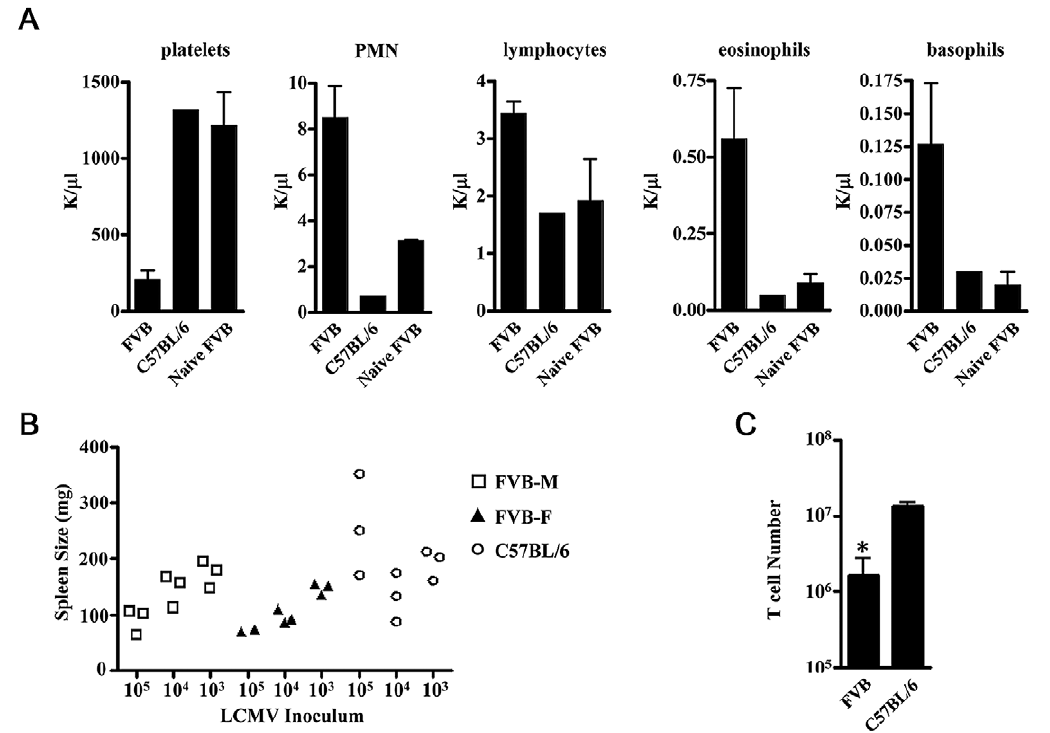
Figure 4. Effects of LCMV infection on blood and splenic cellularity in LCMV infected mice. A) Complete blood count with differential of LCMV-13 infected mice for platelet, neutrophil, lymphocyte, eosinphil and basophil counts. FVB (n=4) or C57BL/6 (n=1) mice were infected with 1– 2 6 10 6 p.f.u. LCMV-13 and blood was taken at day 7 post-infection. Additionally, naı¨ve FVB (n=2) blood was collected as a reference. Counts are presented as mean + / 2 standard deviation. Results for FVB mice are combined from two independent experiments. B) Spleen size in FVB mice exhibits an inverse correlation with infections dose of LCMV compared to C57BL/6. C) FVB mice have reduced T cell numbers as assessed by staining with anti-CD3 antibody in spleens after LCMV-13 infection. FVB (n=10) or C57BL/6 (n=8) mice were infected with 1–2 6 10 6 p.f.u. LCMV-13 and spleens were harvested between day 7–11 post-infection. Results are presented as mean + / 2 standard deviation (*, p , 0.05. t-test). Similar results were found in two additional independent